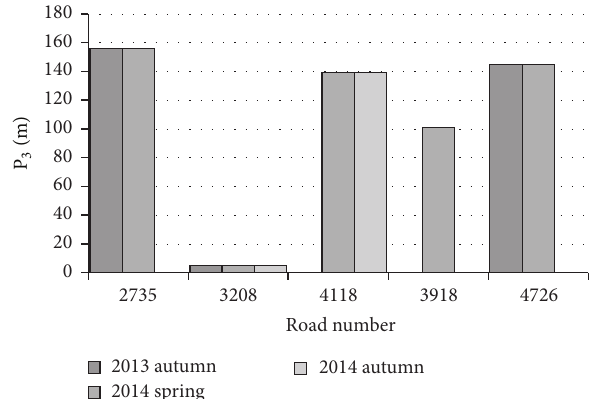
Figure15:P 3 (streaking)onroadssectionscoveredwithdoubleOtta